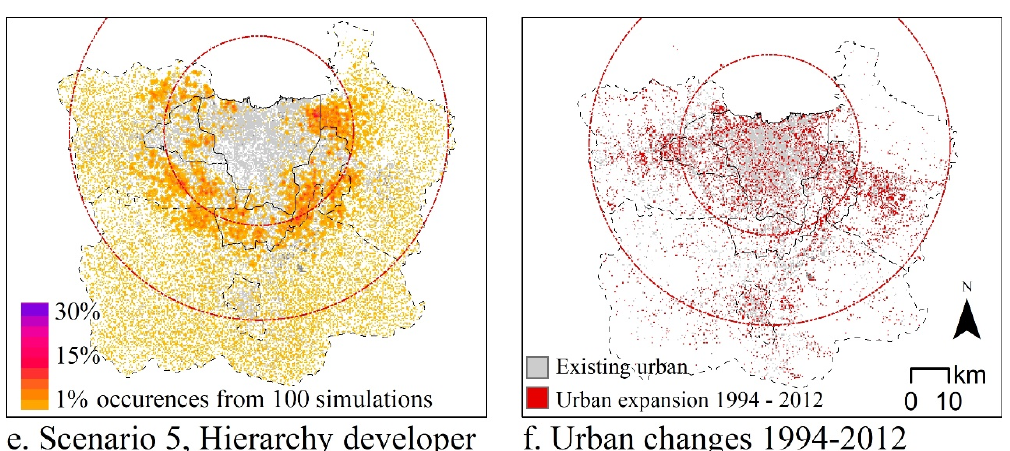
Figure 4. New urban areas at t = 216 months (or 18 years) generated from the ABM after 100 simulations under different scenarios. The first and second radial lines represent 25 km and 50 km distance to Jakarta’s CBD, respectively. Jakarta’s CBD, respectively.